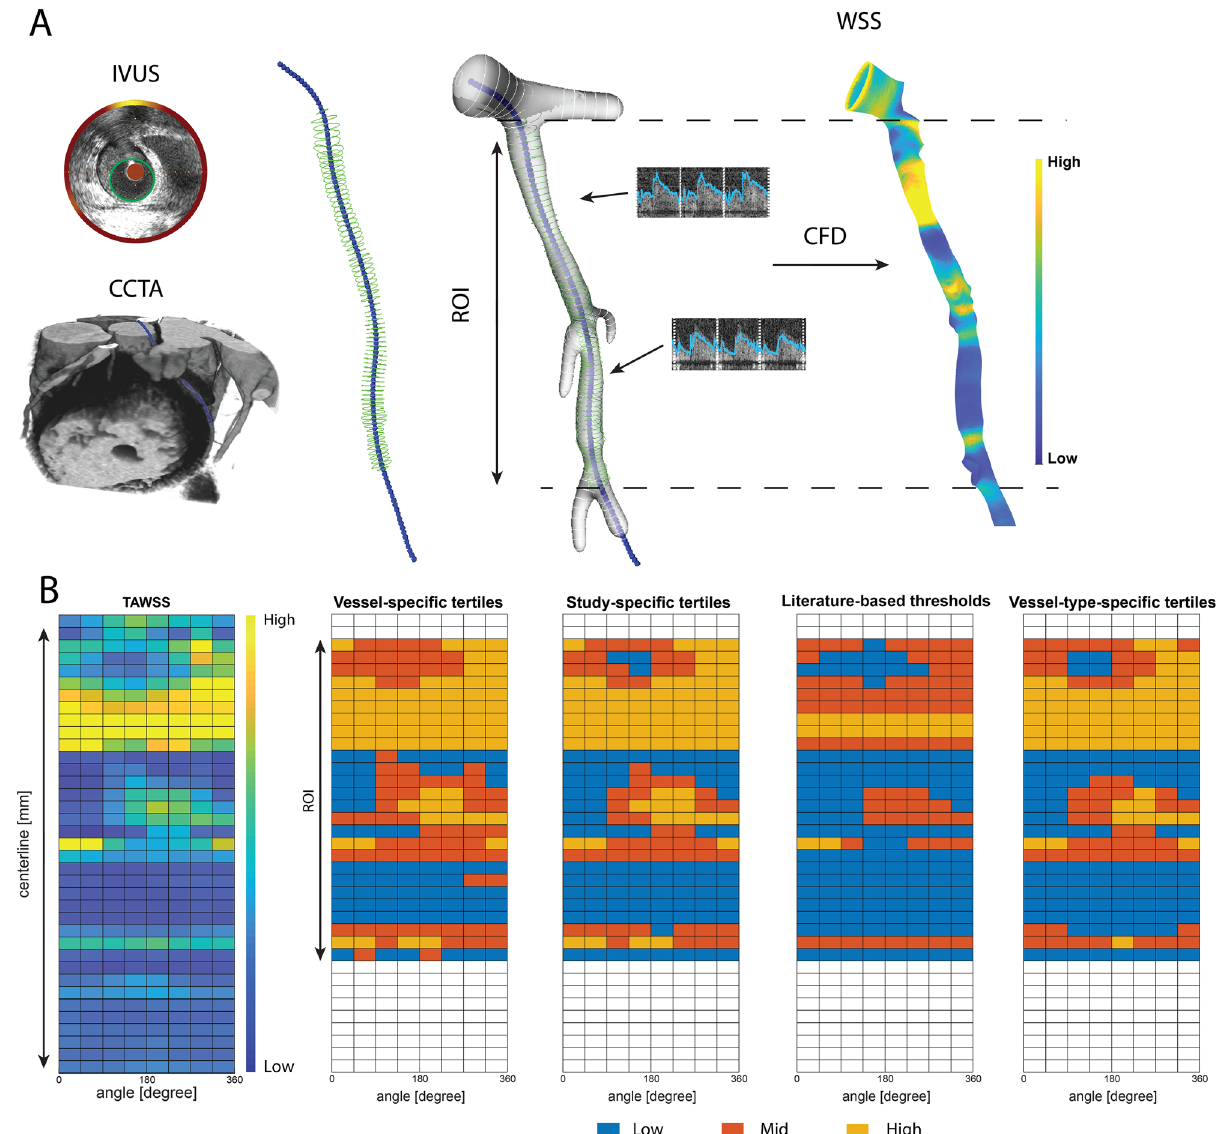
Figure 5. Example of an LCX showing the methodology of 3D-reconstruction of coronary and wall shear stress (WSS) calculations. ( A ) Lumen (green) was delineated in intravascular ultrasound (IVUS) images and merged with the centerline (blue markers) segmented from the coronary computer tomography angiography (CCTA) to create a 3D reconstruction. WSS calculations were performed using local flow measurements and computational fluid dynamics, resulting in local WSS. ( B ) The 3D reconstruction was converted in a 2D-map by folding the vessel open in the longitudinal direction. Creating a 2D map, dividing the vessel into sectors of 45°/1.5 mm thick , WSS was averaged for each sector . For each methodology (vessel-specific tertiles, study-specific tertiles, literature-based thresholds (low WSS < 1.0 Pa) and vessel-type-specific tertiles) a 2D map was created and depicting the distribution of WSS in low (blue), mid (orange) and high (yellow) WSS. Images were generated by MevisLab (MeVis Medical Solutions AG, Bremen, Germany) and MATLAB (v 2017B, Mathworks Inc,